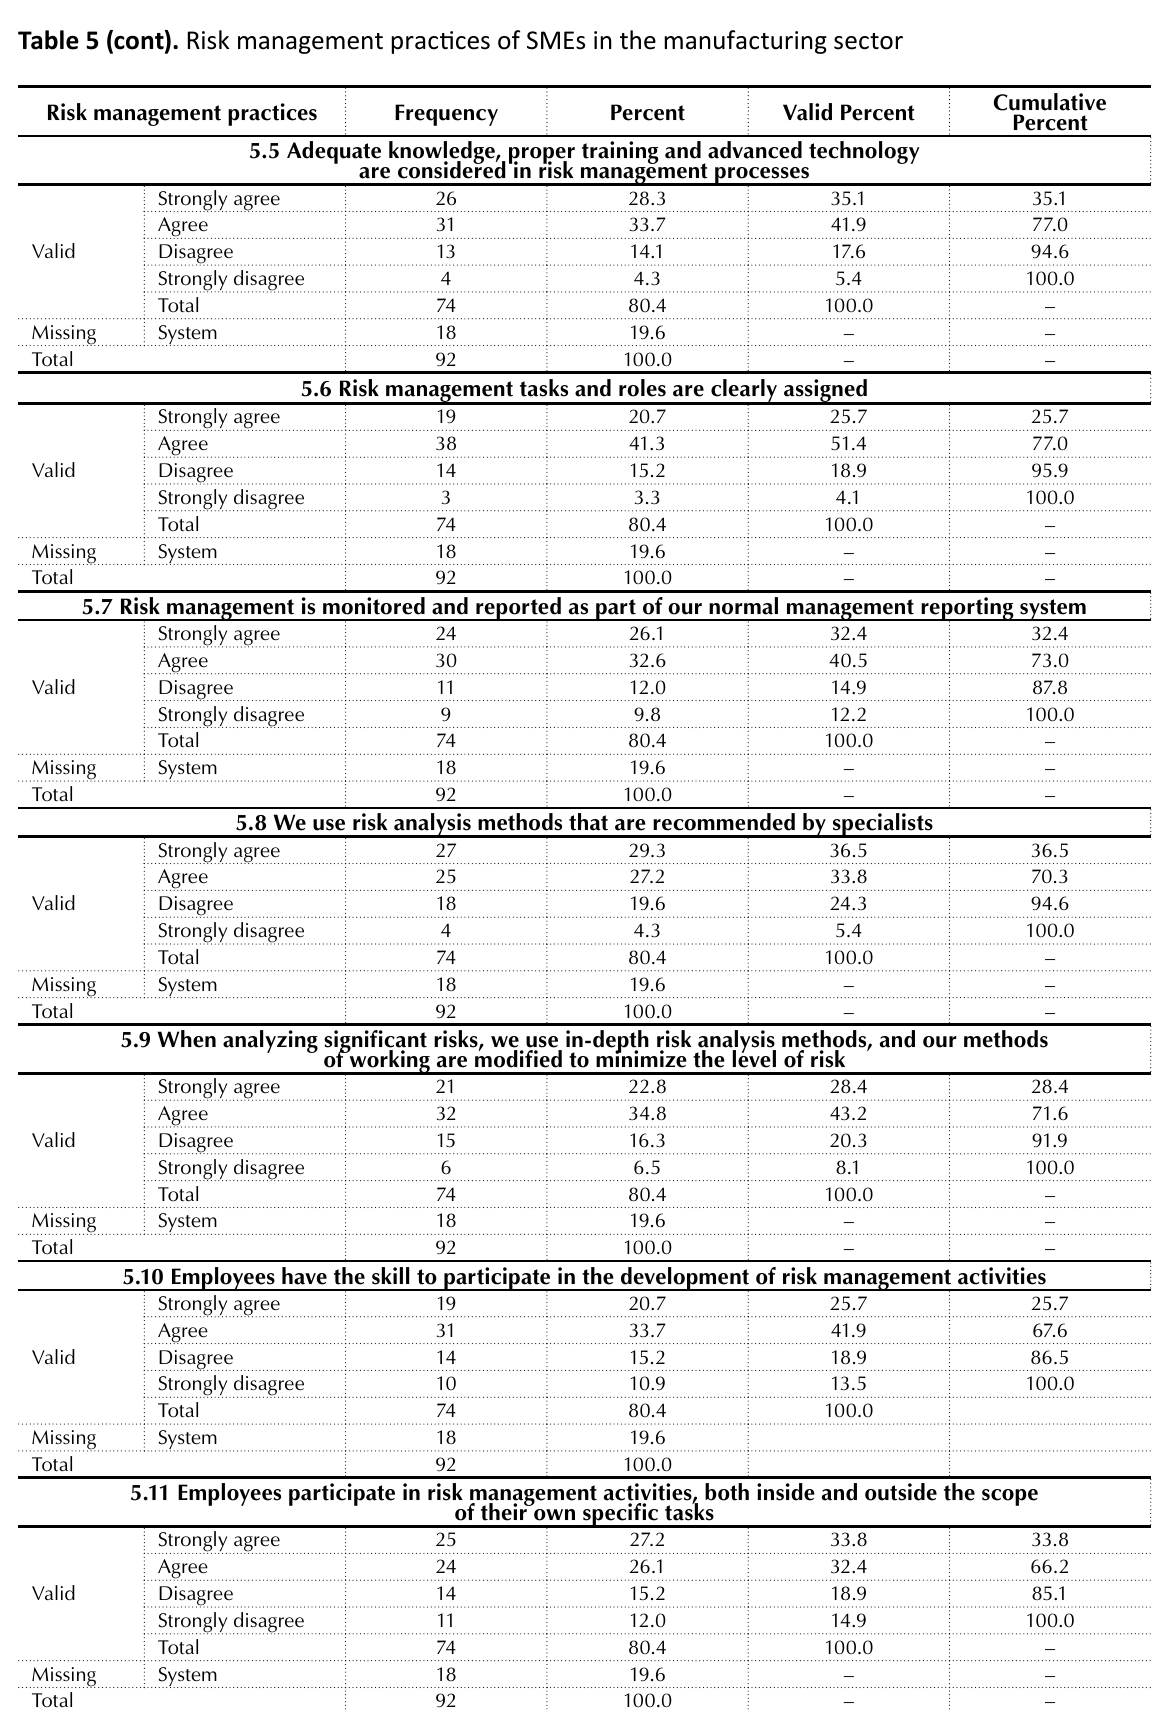
Table 5 (cont). Risk management practices of SMEs in the manufacturing sector Risk management practices Frequency Percent